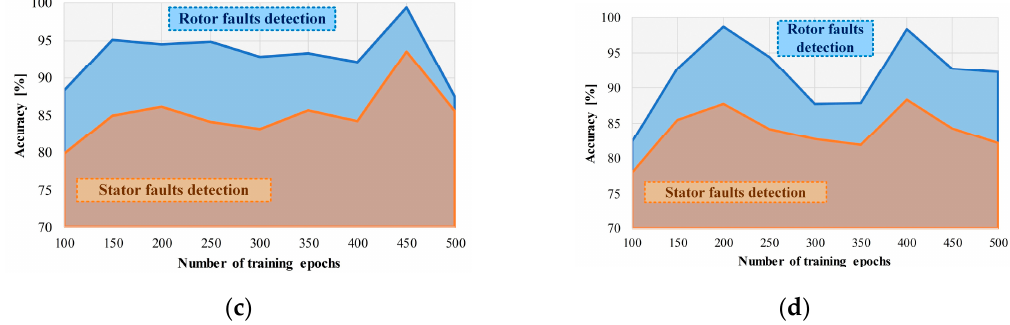
Figure 8. The influence of the MLP structure and number of teaching epochs on the fault detection efficiency: ( a ) structure {3-15-12-2}; ( b ) structure {3-12-8-2}; ( c ) structure {3-10-6-2}; ( d ) structure {3-8-4-2}.